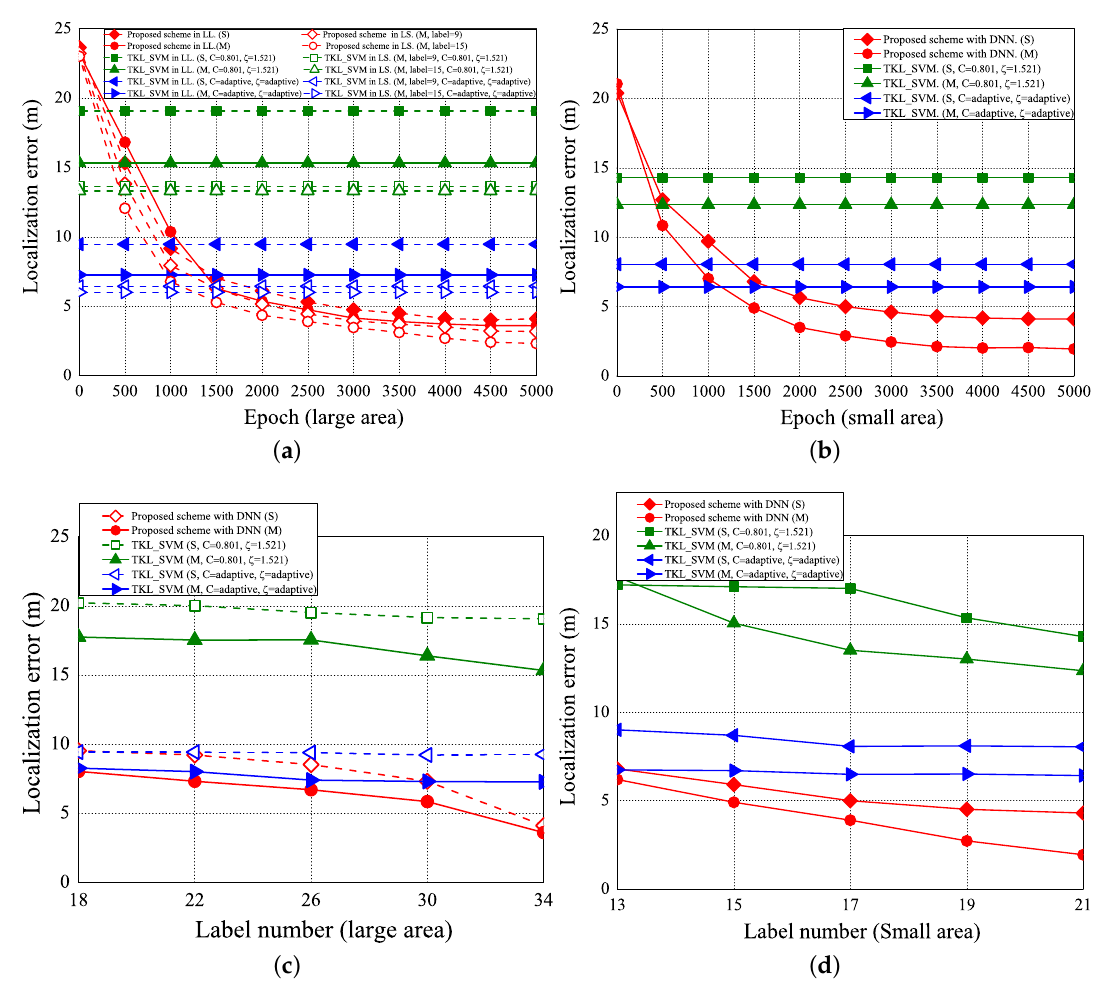
Figure 12. ( a )Localization error (large area) vs. per epoch; ( b ) localization error (small area) vs. per epoch; ( c ) localization error (large area) vs. number of labelled samples; ( d ) localization error (small area) vs. number of labelled